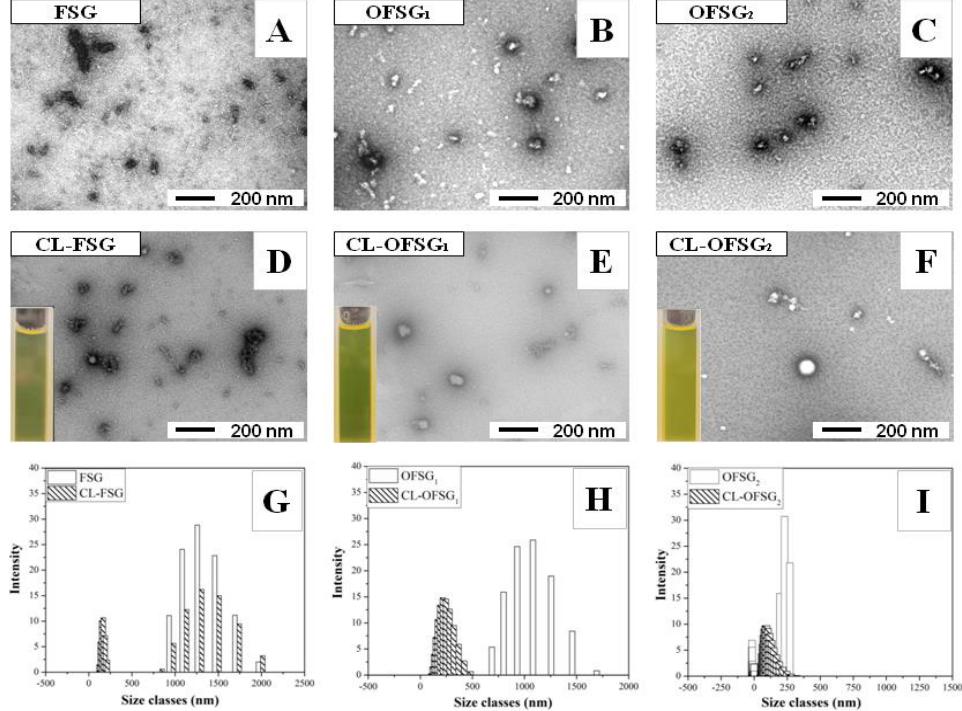
Figure 3. Transmission electron microscopy (TEM, A – F ), particle size distribution (PSI, G – I ) of fish scale gelatin (FSG) and octenylsuccinate fish scale gelatin (OFSG 1 , degree of substitution = 0.026; OFSG 2 , degree of substitution = 0.107) with (CL-FSG, CL-OFSG 1 and CL-OFSG 2 ) or without the loading of curcumin.